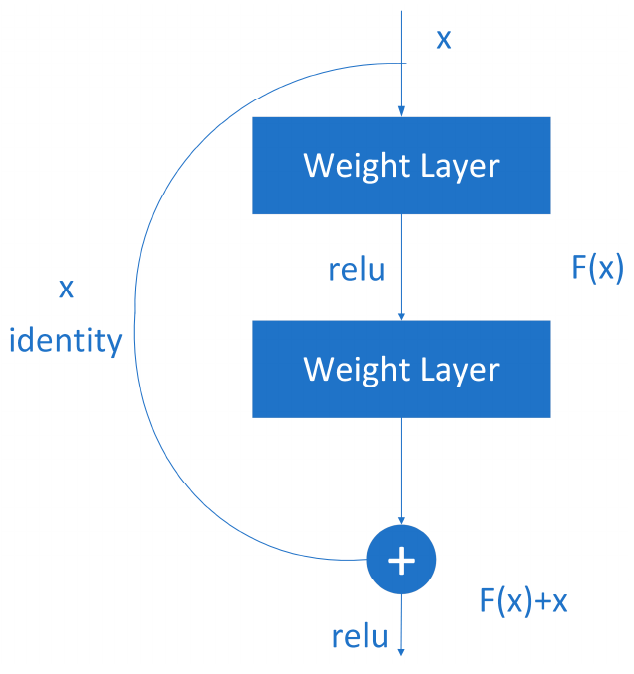
Figure 5. Residual